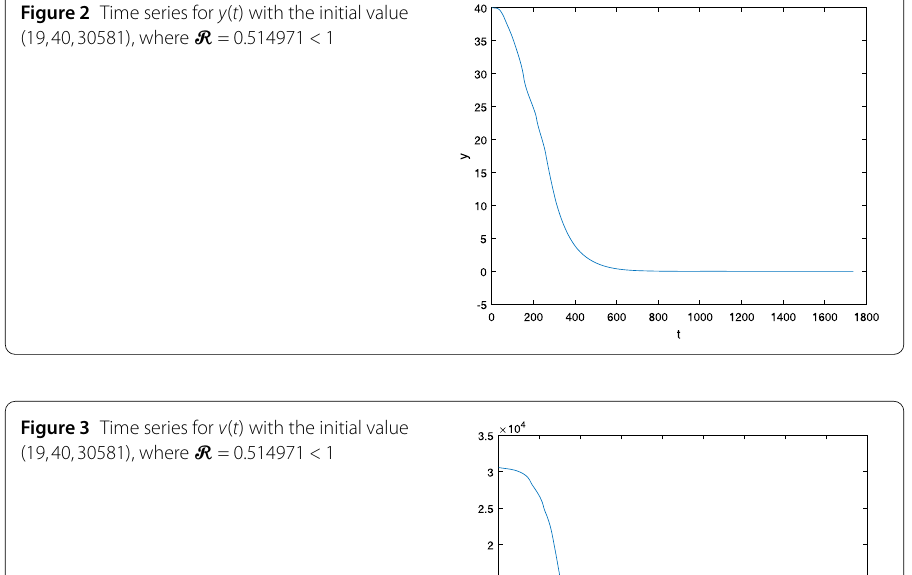
Figure 3 Time series for v ( t ) with the initial value (19,40,30581), where R = 0.514971 < 1